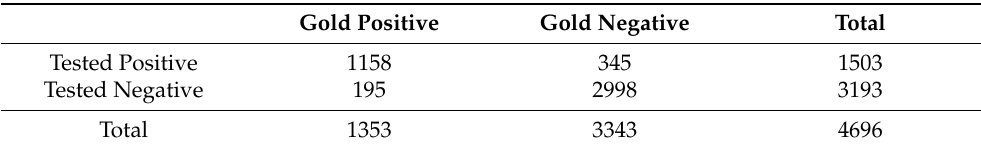
Table 2. Two-way table of the algorithm-based and the gold-standard classification. Gold Positive Gold